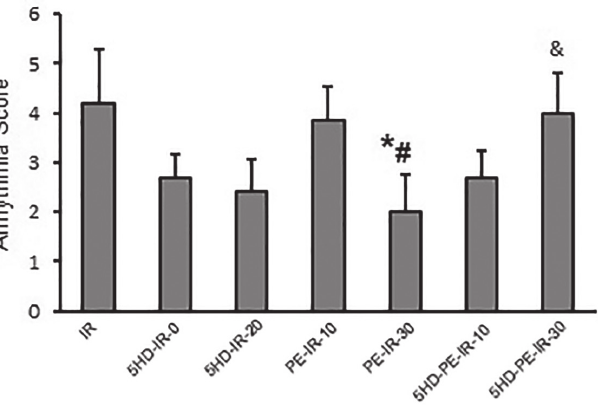
FIGURE 5 - Distribution of the arrhythmia score (severity) during 35 min ischemia in ischemia/reperfusion (IR), 5HD perfused at onset of regional ischemia (5HD-IR-0), 5HD perfused 20 min after regional ischemia (5HD-IR-20), phenylephrine-early perconditioning 10 min after ischemia (PE-IR-10), phenylephrine-late perconditioning 30 min after ischemia (PE-IR-30), 5HD-phenylephrine Early perconditioning (5HD-PE-IR-10), 5HD-phenylephrine-late perconditioning (5HD-PE-IR-30) groups. Data are presented as mean ± SEM. * P < 0.05 vs. IR. # P < 0.05 vs. PE-IR-10 group. & P < 0.05 vs. PE-IR-30 group.